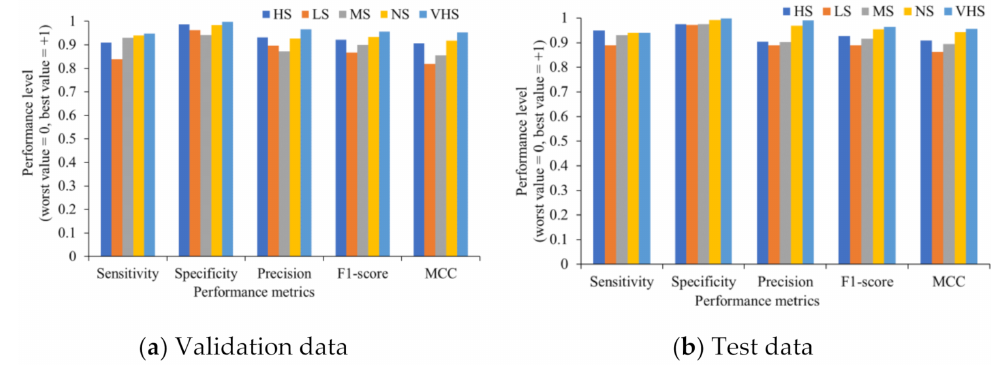
Figure 8. Evaluation of the individual stress